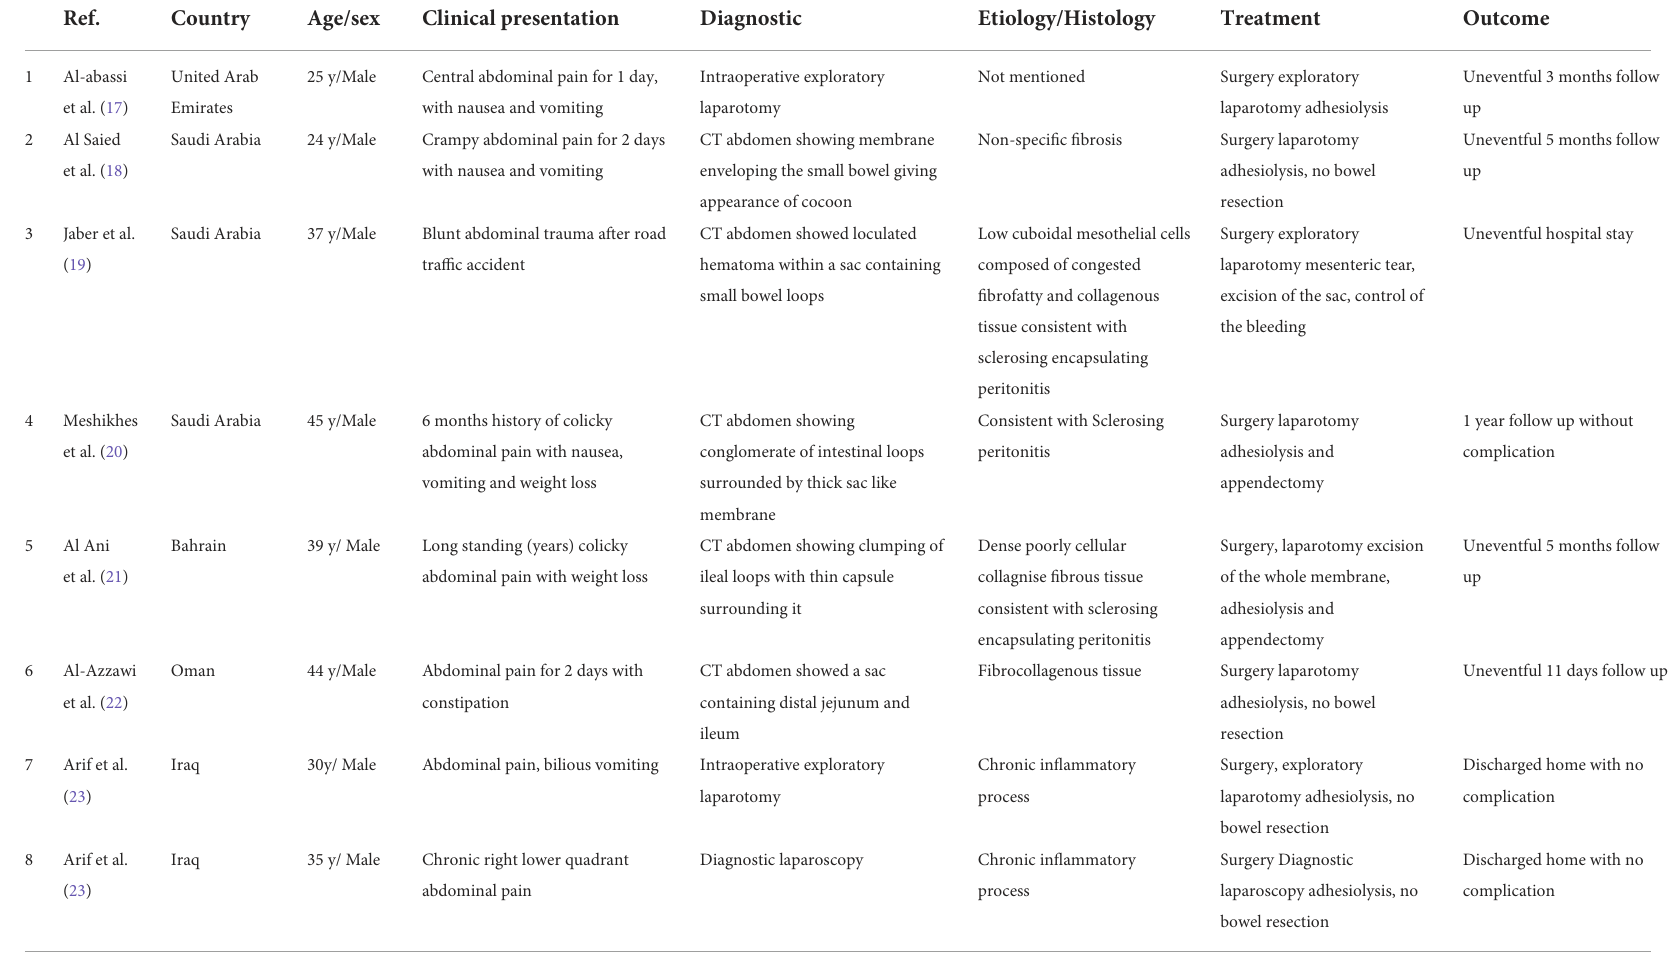
TABLE 2 Clinical summary of reported cases in the Arabian Gulf region.